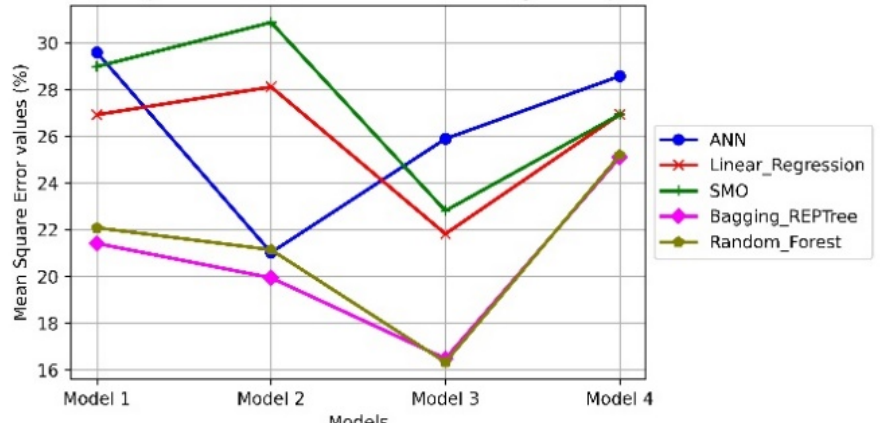
Figure 4. The MSE results of using ML techniques on YouTube dataset.